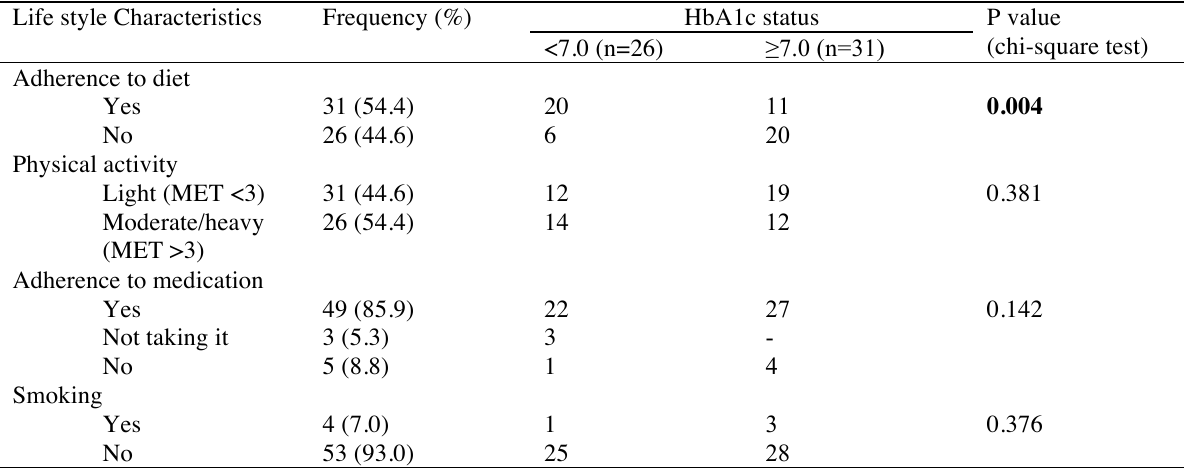
Table 3 Life style of study subjects and HbA1c